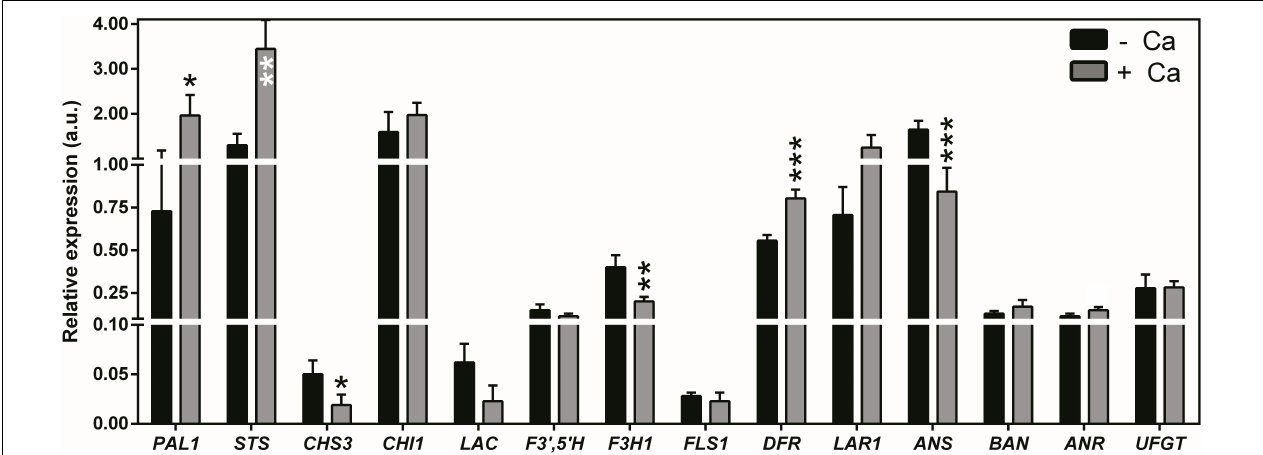
FIGURE 5 | Transcript levels of genes encoding enzymes of secondary metabolism core branches in berries from vines cv. Loureiro treated with Ca (+ Ca) or without treatment (– Ca). Transcript levels are shown for phenylalanine ammonia lyase ( PAL1 ), stilbene synthase ( STS ), polyphenol oxidase/laccase ( LAC ), chalcone synthase ( CHS3 ), chalcone isomerase ( CHI1 ), flavonoid 3 (cid:48) ,5 (cid:48) -hydroxylase ( F3 (cid:48) ,5 (cid:48) H ), flavanone 3-hydroxylase ( F3H1 ), flavonol synthase ( FLS1 ), dihydroflavonol 4-reductase ( DFR ), leucoanthocyanidin reductase ( LAR1 ), anthocyanidin synthase ( ANS ), anthocyanidin reductases ( BAN and ANR ), and anthocyanidin 3- O -glucosyltransferase (UDP–glucose:flavonoid-3- O -glucosyltransferase , UFGT ). Expression levels were normalized to the transcript levels of GAPDH and ( ACT1 ) (housekeeping genes). Results are expressed as mean ± SD and asterisks denote statistical significance as compared to control (– Ca): * P ≤ 0.05; ** P ≤ 0.01; and *** P ≤ 0.001; n = 3.